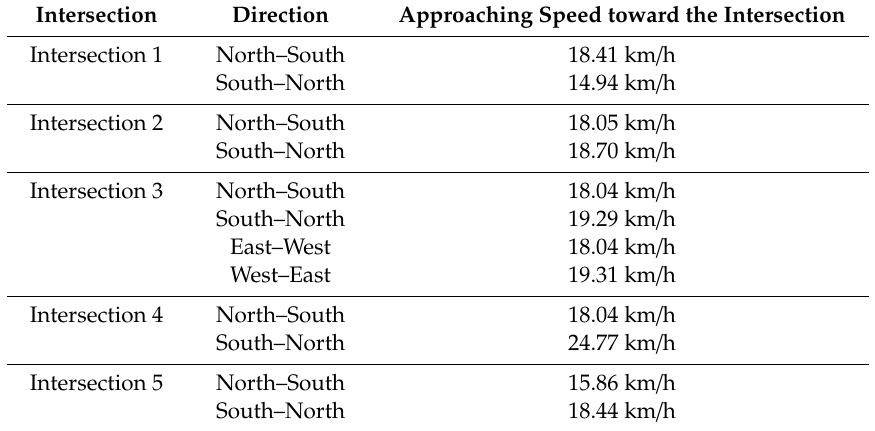
Table 3. Average approaching speed on the considered intersection movements, as derived from the floating bike